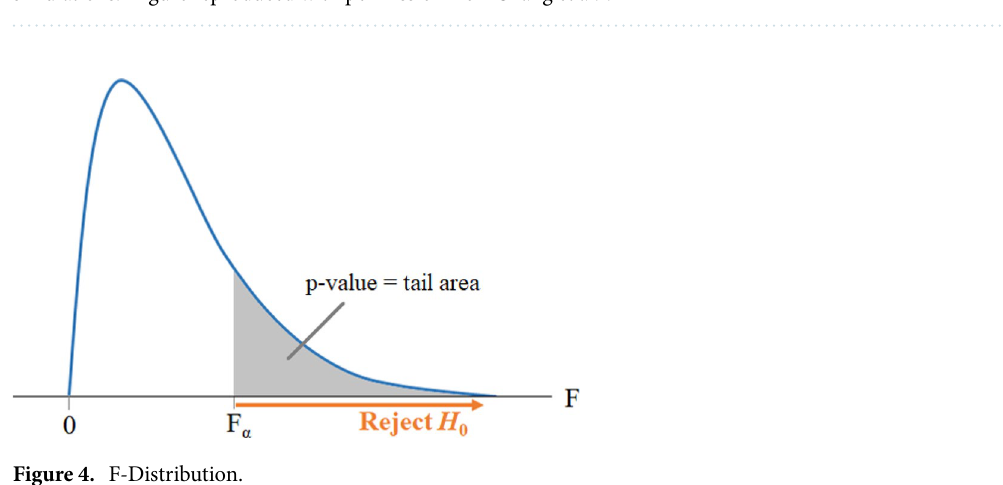
Figure 3. Histogram of powder particles’ distribution used in experiments by Wan et al. 3 and in the current simulations. Figure reproduced with permission from Shang et al. 2 .